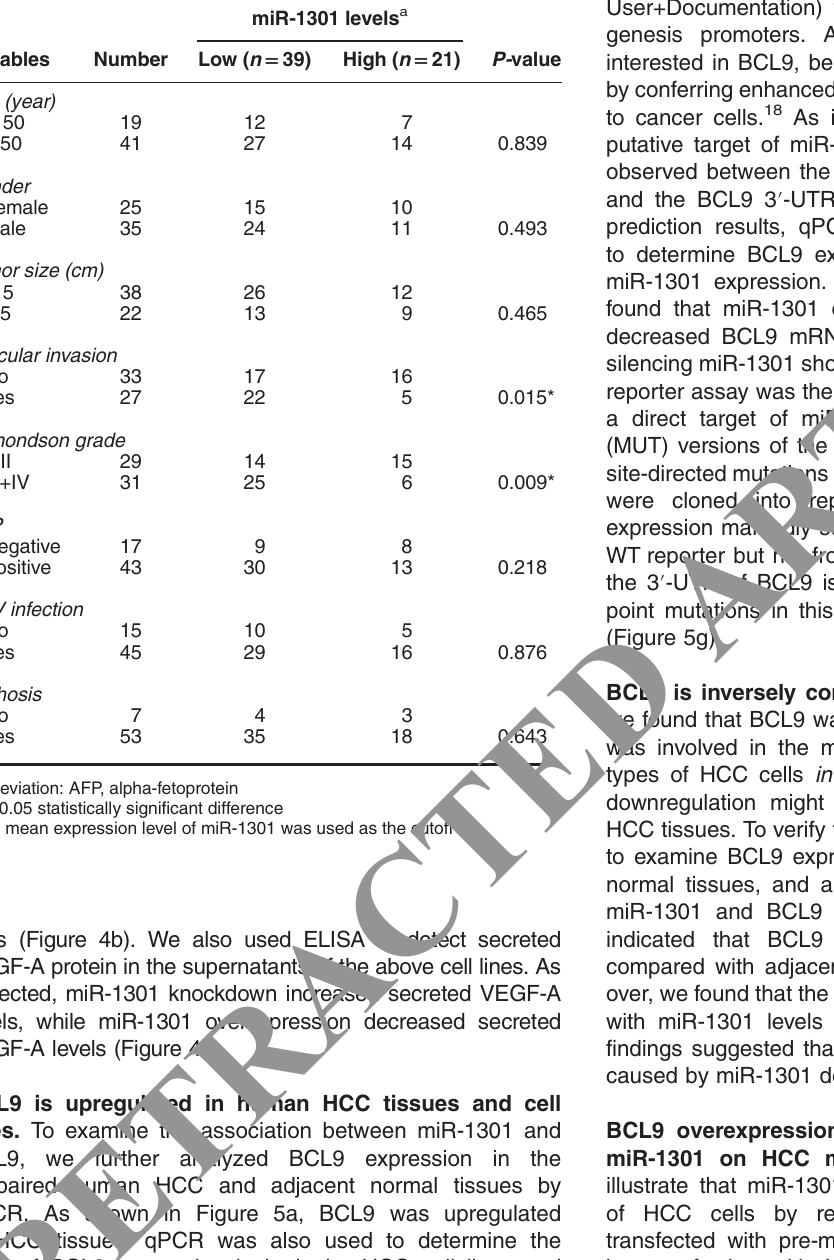
Table 1 Association between miR-1301 expression and clinicopathologic features of patients with hepatocellular carcinoma miR-1301 levels